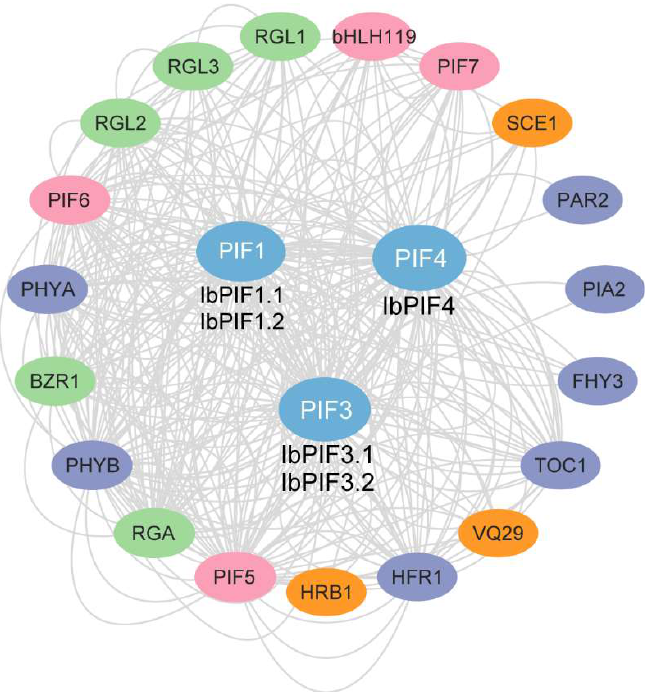
Figure 5. Functional interaction networks of IbPIFs in I. batatas according to orthologues in A. thaliana. Network nodes represent proteins, and lines represent protein–protein associations.